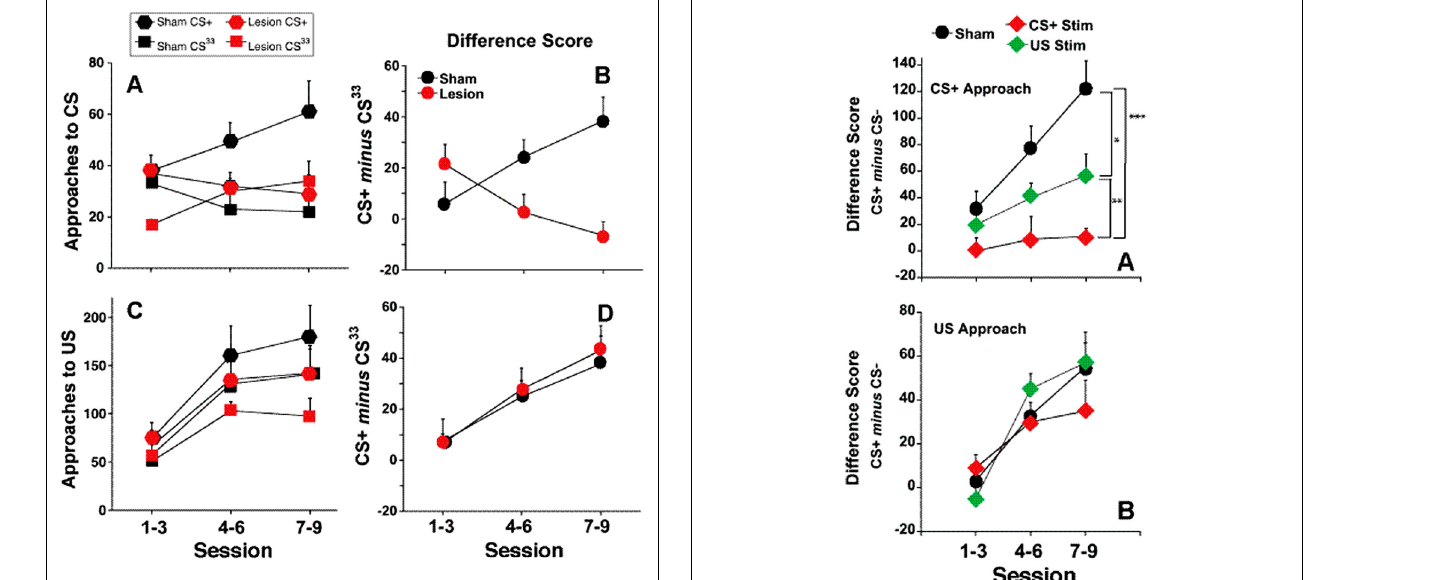
FIGURE 4 | Electrical stimulation of the fr during CS + or US presentation. (A) represents the effects of fr stimulation during CS + presentation on conditioned approach to the CS + vs. the CS − as described by the Difference Score (same dependent variable as seen in Figures 1 and 2 ). (B) represents the effects of fr stimulation during US presentation. n = 8, 7, 8 for the Sham, CS + Stim and US Stim groups. Error bars represent S.E.M. Difference between experimental groups: *** p < 0.001, ** p < 0.01, * p <